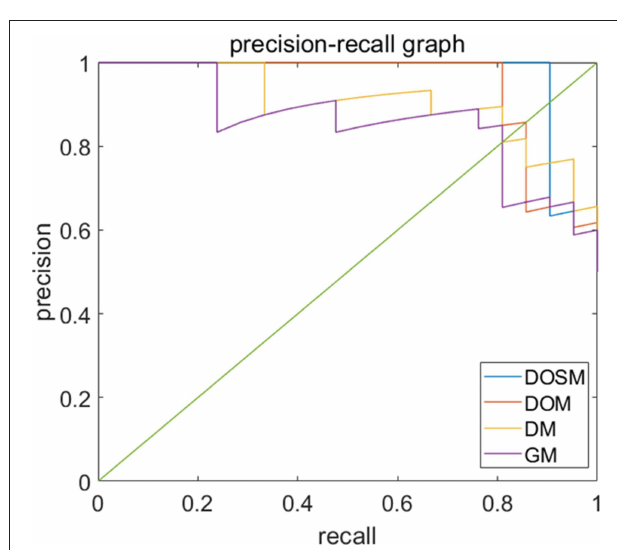
FIGURE 6 | Precision-recall curves of models for prediction of MVI. Precision–recall curves (PRC) of GM, DM, DOM, and DOSM models for prediction of microvascular invasion (MVI). The DOSM based on three ultrasound feature maps selected from radio frequency signals (ORF) signals showed the best performance among GM, DM, DOM, and DOSM models in predicting the MVI classification of HCC.